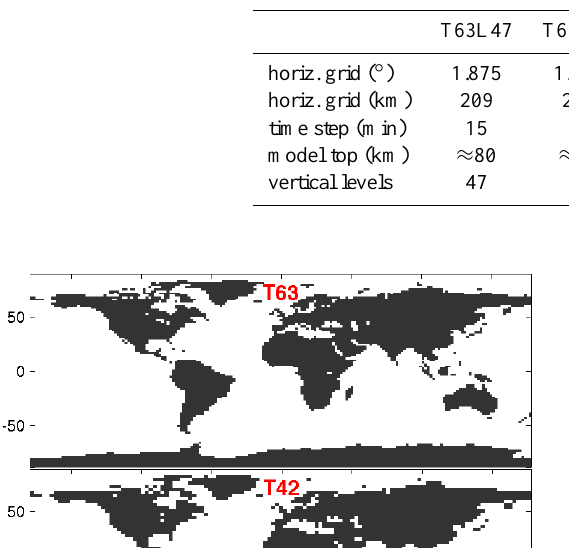
Table 1. Details of model resolutions (horizontal and vertical) used in this study